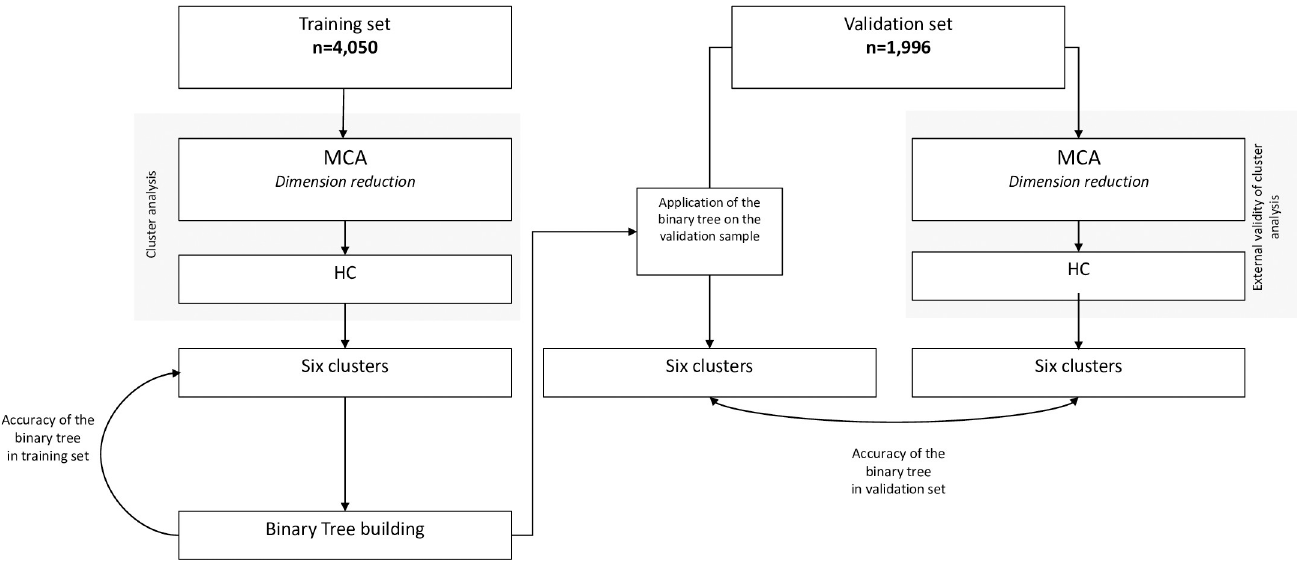
Fig 1. Schematic of study. Definition of abbreviations: MCA = multiple correspondence analysis; HC = hierarchical clustering Sensitivity analyses: Cluster analysis in the training set after excluding COPD exacerbation and cluster analysis in the training set after excluding the data before 2008.